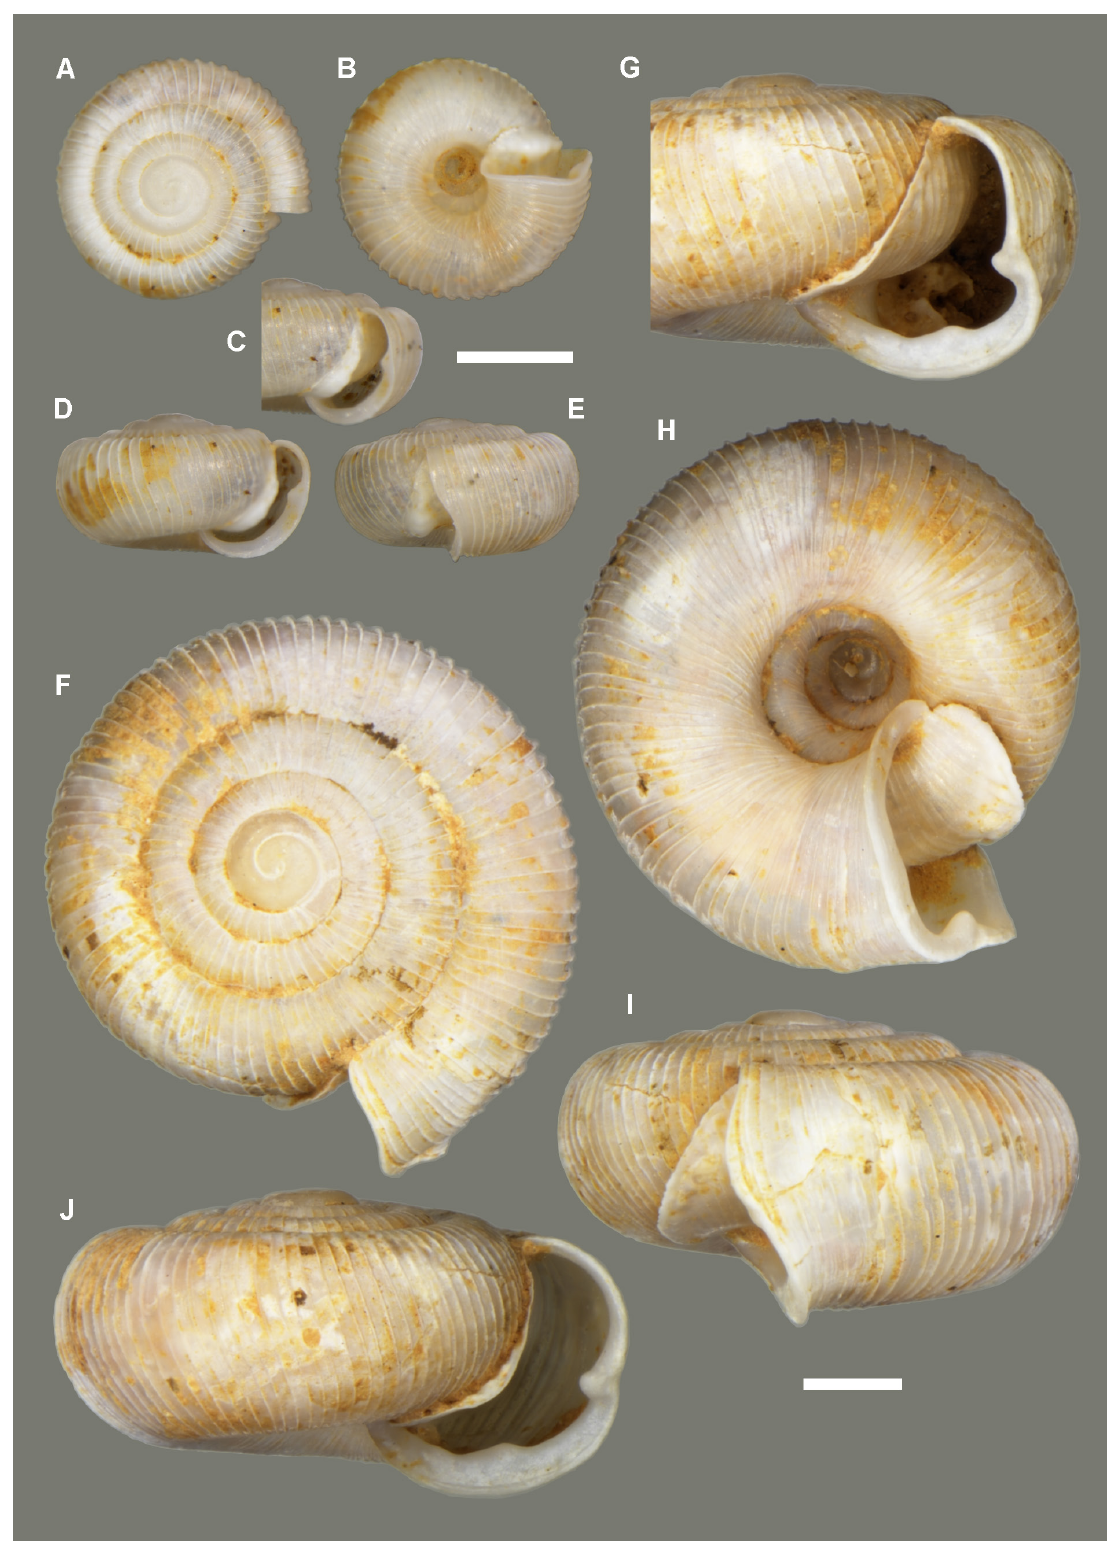
Fig. 4. Shells of species of Virpazaria Gittenberger, 1969. A–E . Virpazaria (Virpazaria) gittenbergeri Fehér & Erőss sp. nov., holotype (HNHM 103411). F–J . Virpazaria (Virpazaria) pesici Fehér & Deli sp. nov., holotype (HNHM 103403). Scale bars = 1 mm (note that the latter species is less